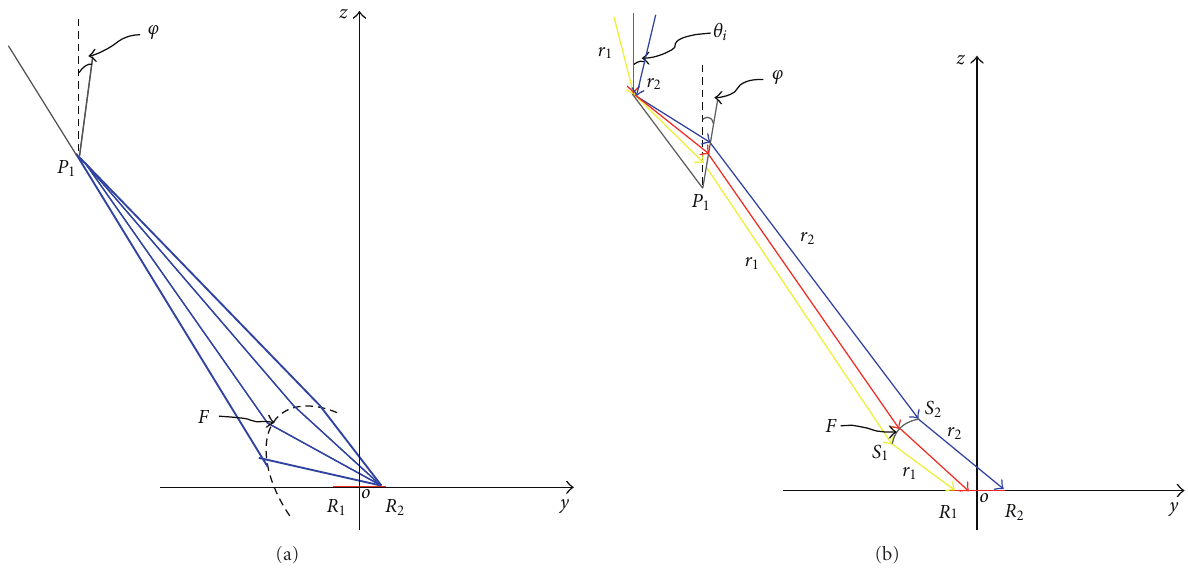
Figure 5: Design of secondary lens. (a) Specification of the type of secondary lens’ front surface. (b) Calculation of the borders of secondary lens’ front surface.